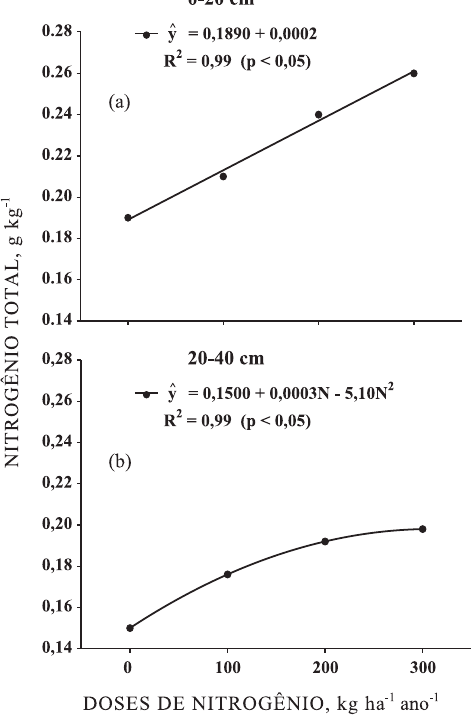
Figura 4. Teor de nitrogênio total do solo nas